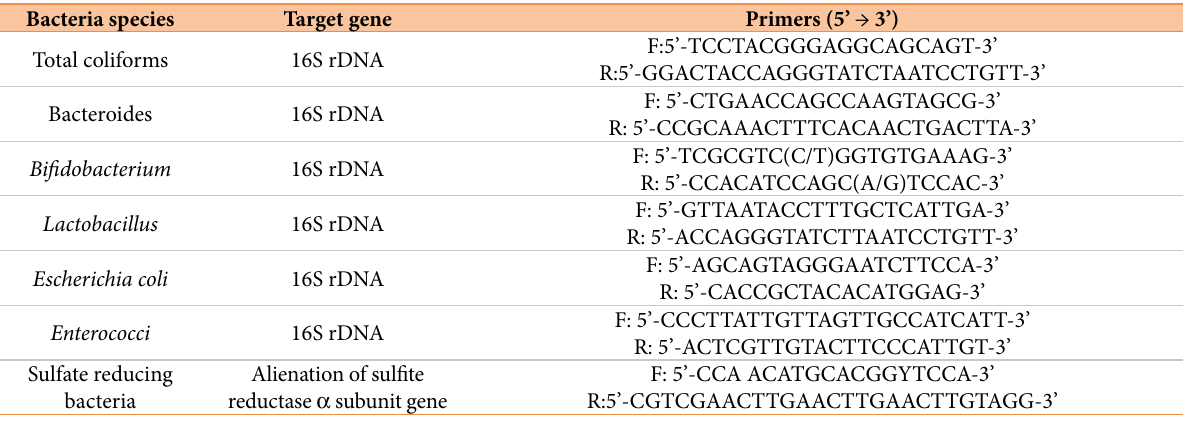
Table 3 - Polymerase chain reaction